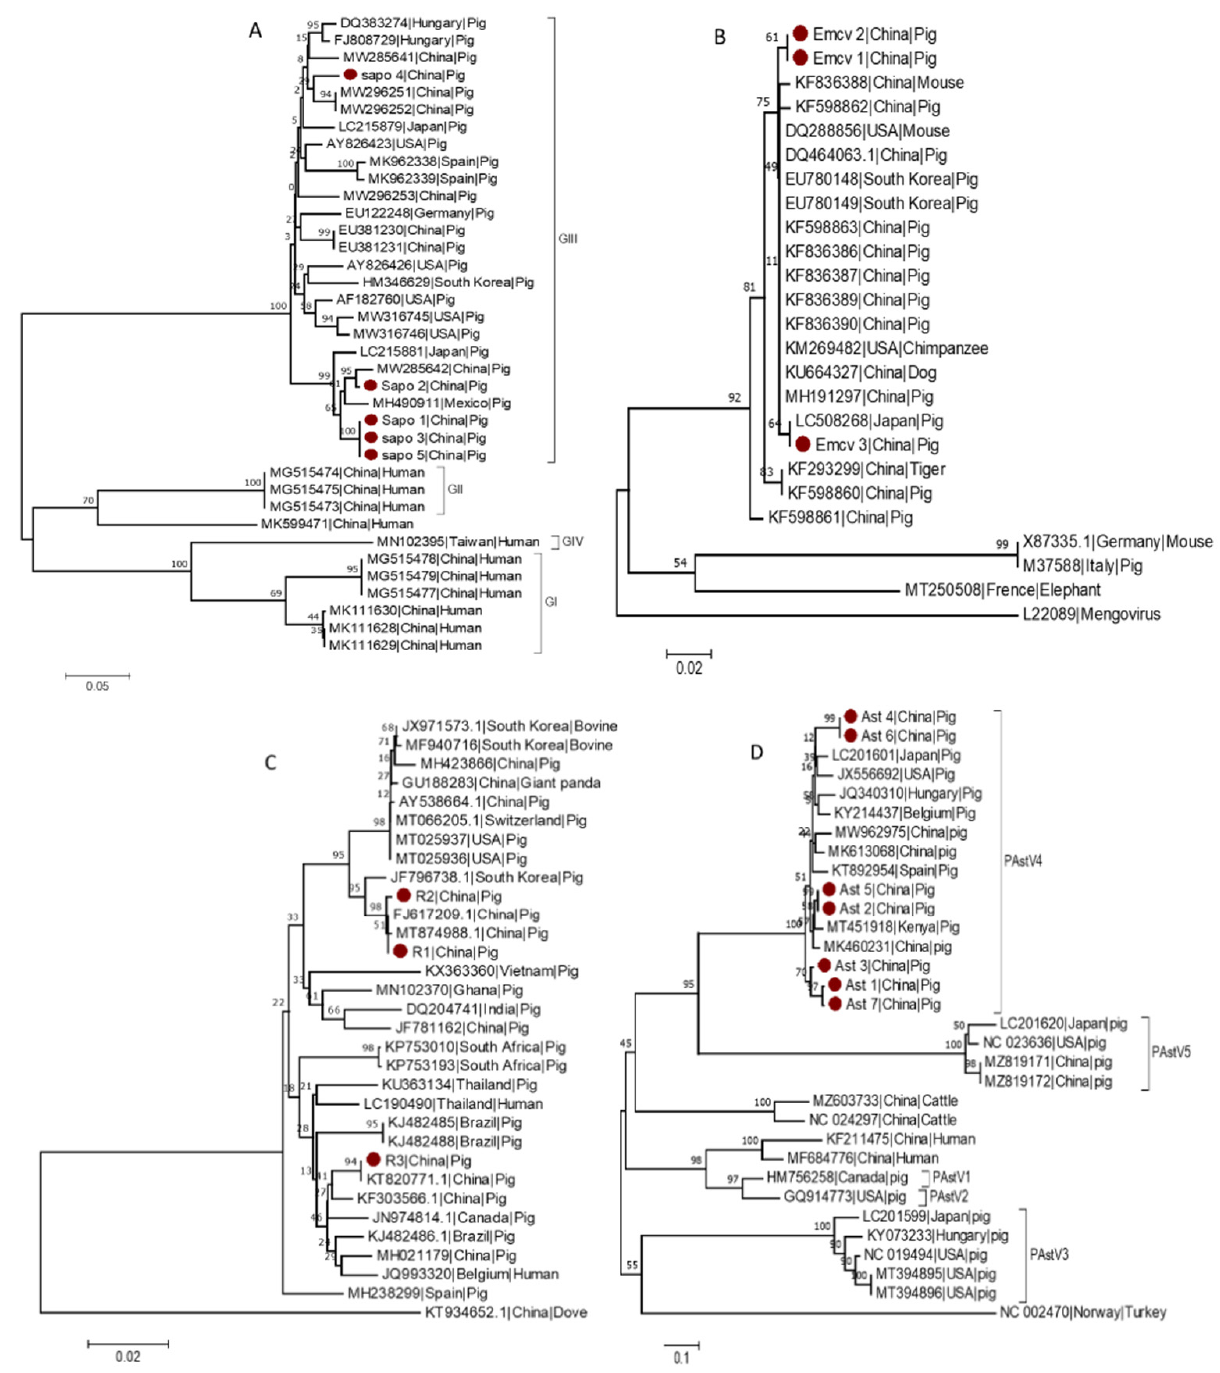
Figure 4. Phylogenetic analysis of SaV, EMCV, RVA and AstV. The strains identified in this study (marked with red dots) and reference strains from GenBank were used to construct phylogenetic trees. Scales indicate units of the number of base substitutions per site. ( A ) Phylogenetic tree of SaV. The tree was built using 224 positions from the ORF1 region of SaV. ( B ) Phylogenetic tree of EMCV. The tree was constructed using 211 positions from the 3D region of the EMCV. Mengovirus was used as an outgroup. ( C ) Phylogenetic tree of RVA. The tree was built based on 545 positions of the VP6 region. Rotavirus A from dove (avian) was used as an outgroup. ( D ) Phylogenetic tree of AstV. The tree was built based on 379 positions of the ORF1ab region. As an outgroup, Turkey (avian) Astrovirus is included.